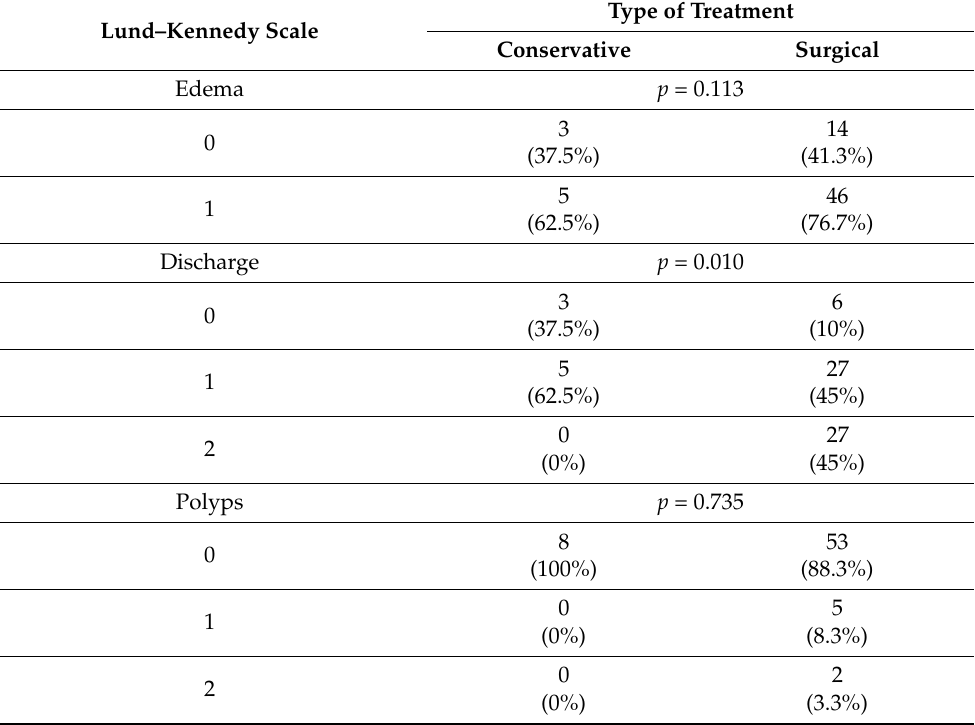
Table 5. Descriptive statistics (number and percentage) and p-values of endoscopic presentation in each treatment group, based on the modified Lund–Mackay